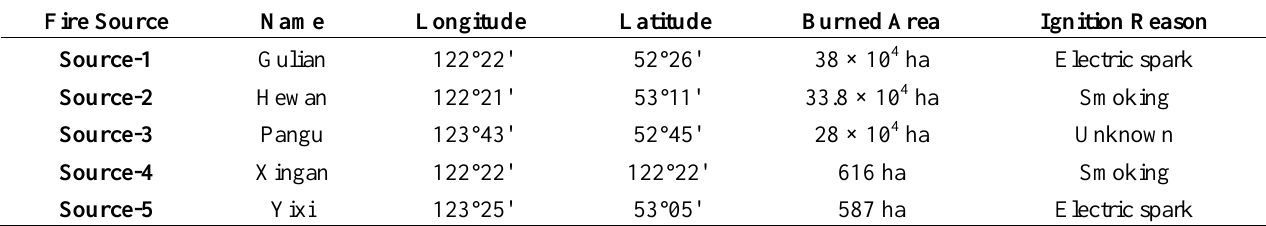
Table 3. Five sources of the 1987 large fire related to Figure